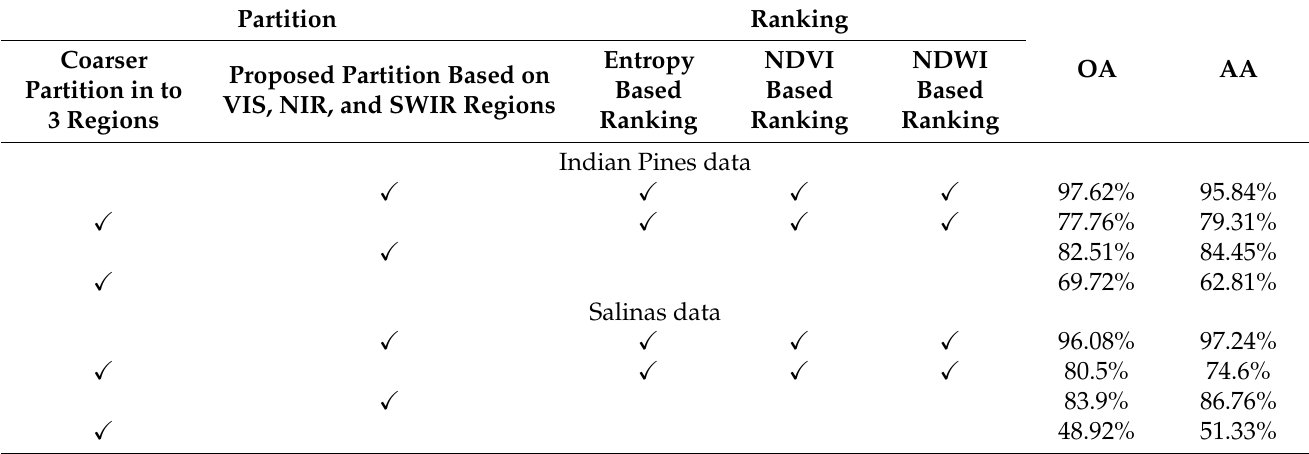
Table 7. Ablation experiments of proposed